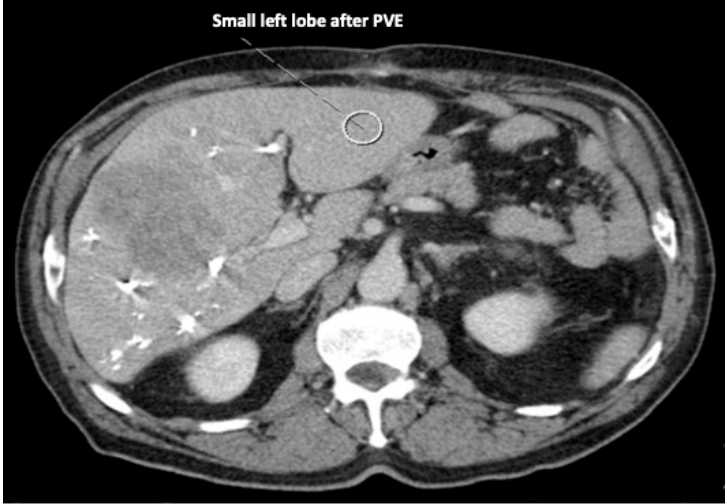
Figure 2. Frequently, even after careful portal venous embolization, the left lobe remains too small to enable a safe resection of the right lobe.